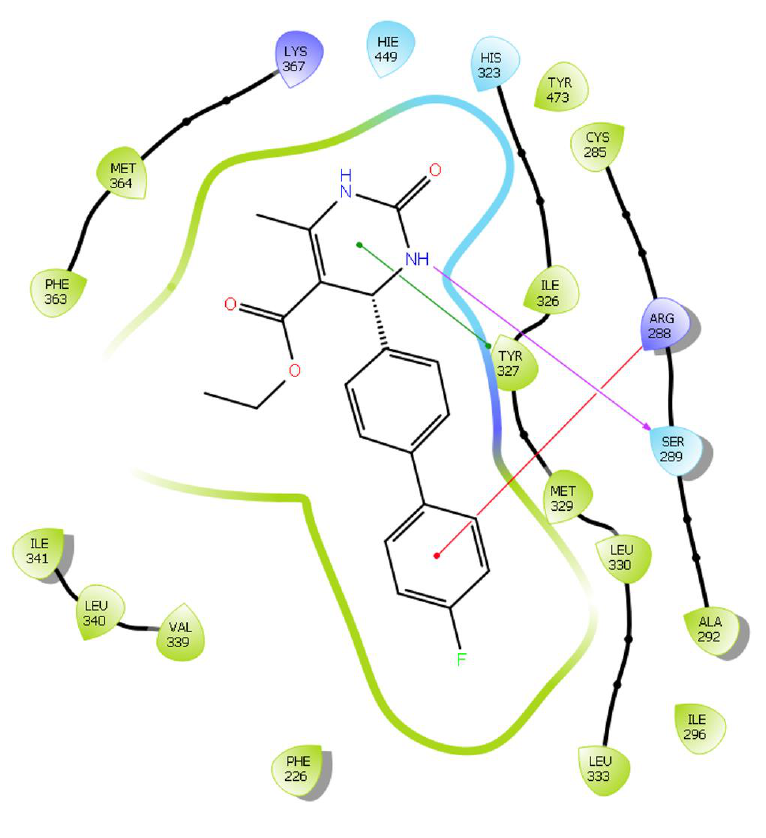
Figure 7. 2D interaction diagram of 4d with the active site residues of PPAR- γ.